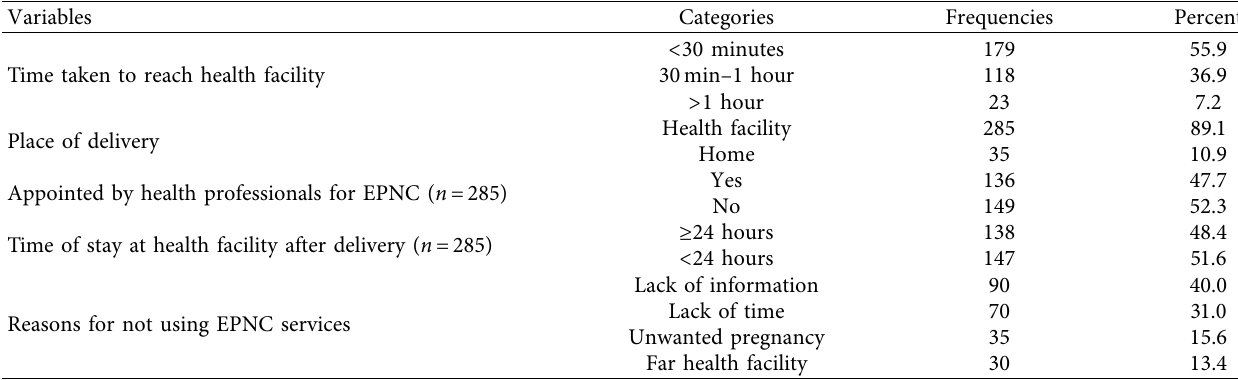
Table 4: Health-care provider and facility-related factors affecting utilization of EPNC in Hawassa Zuria district, Sidama Regional